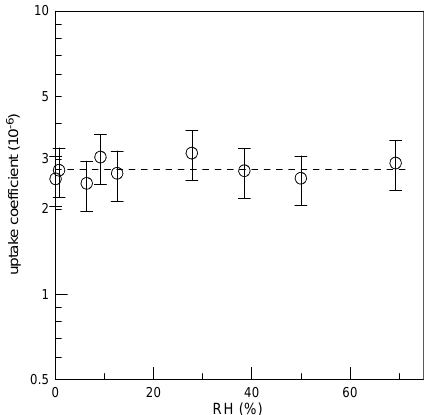
Fig. 8. Uptake coefficient as a function of relative humidity: T = ∼= 0.006s − 1 , sample mass=0.38mgcm − 1 , 280K, P = 9Torr, J NO 2 Figure 8.